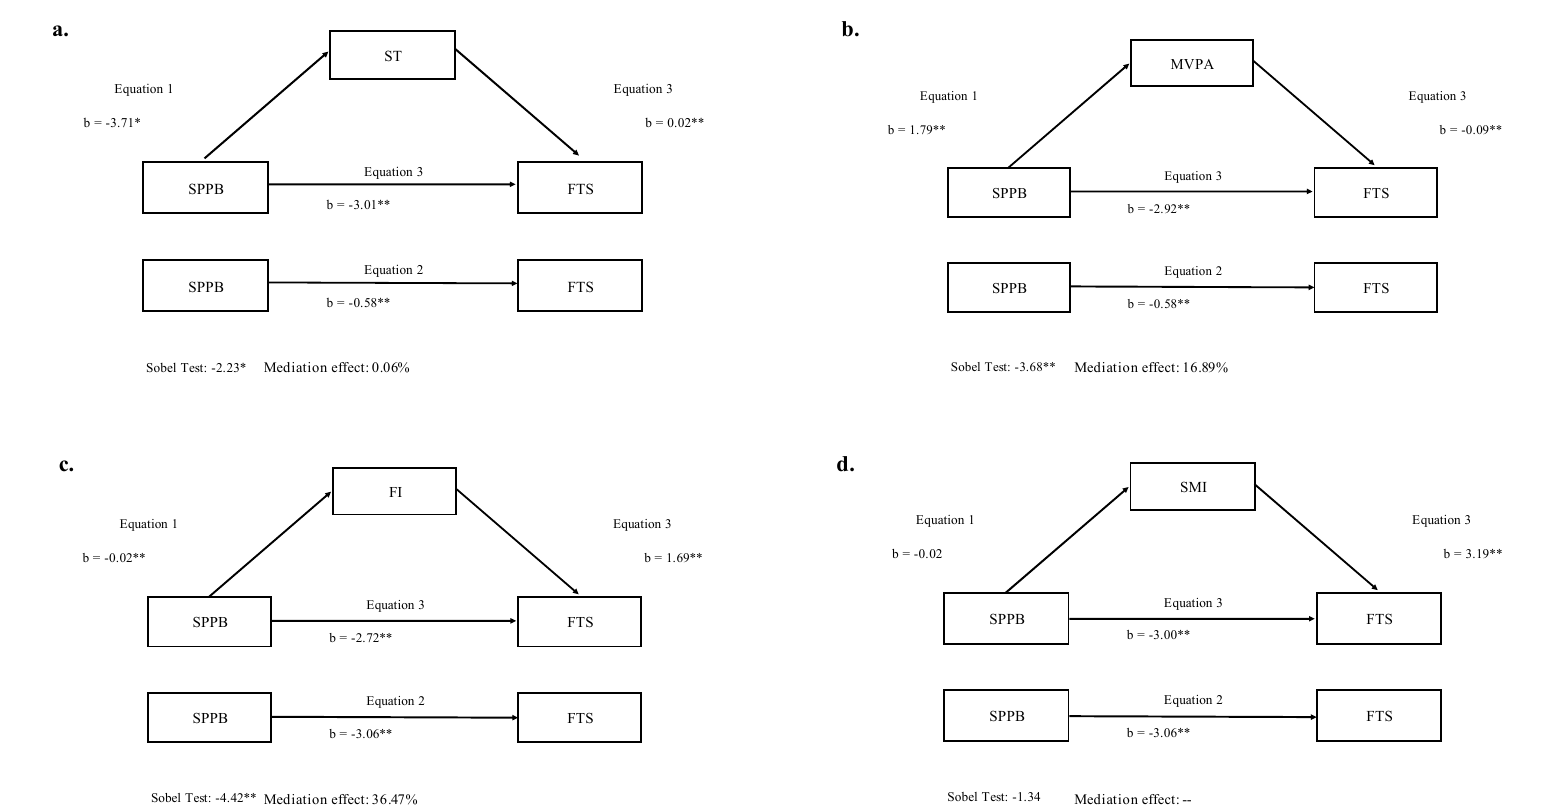
Figure 1. Simple mediation models of the associations between physical fitness (SPPB) and frailty (FTS), with movement behaviors and body composition as independent mediators in older adults. ( a ) Association between SPPB and FTS mediated by sedentary time (ST); ( b ) Association between SPPB and FTS mediated by moderate-to-vigorous physical activity (MVPA); ( c ) Association between SPPB and FTS mediated by fat index (FI); ( d ) Association between SPPB and FTS mediated by skeletal muscle index (SMI). * p < 0.05; ** p < 0.001. All models were adjusted for age, sex and educational status.